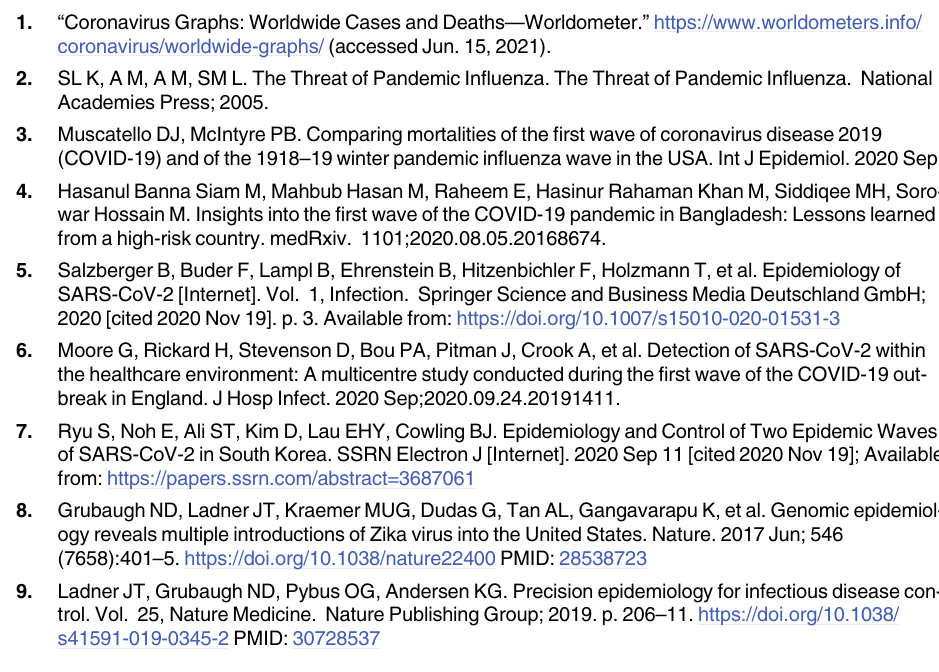
S1 Fig. Molecular phylogeny. Molecular phylogeny of SARS-CoV-2 genomes from Bangla-